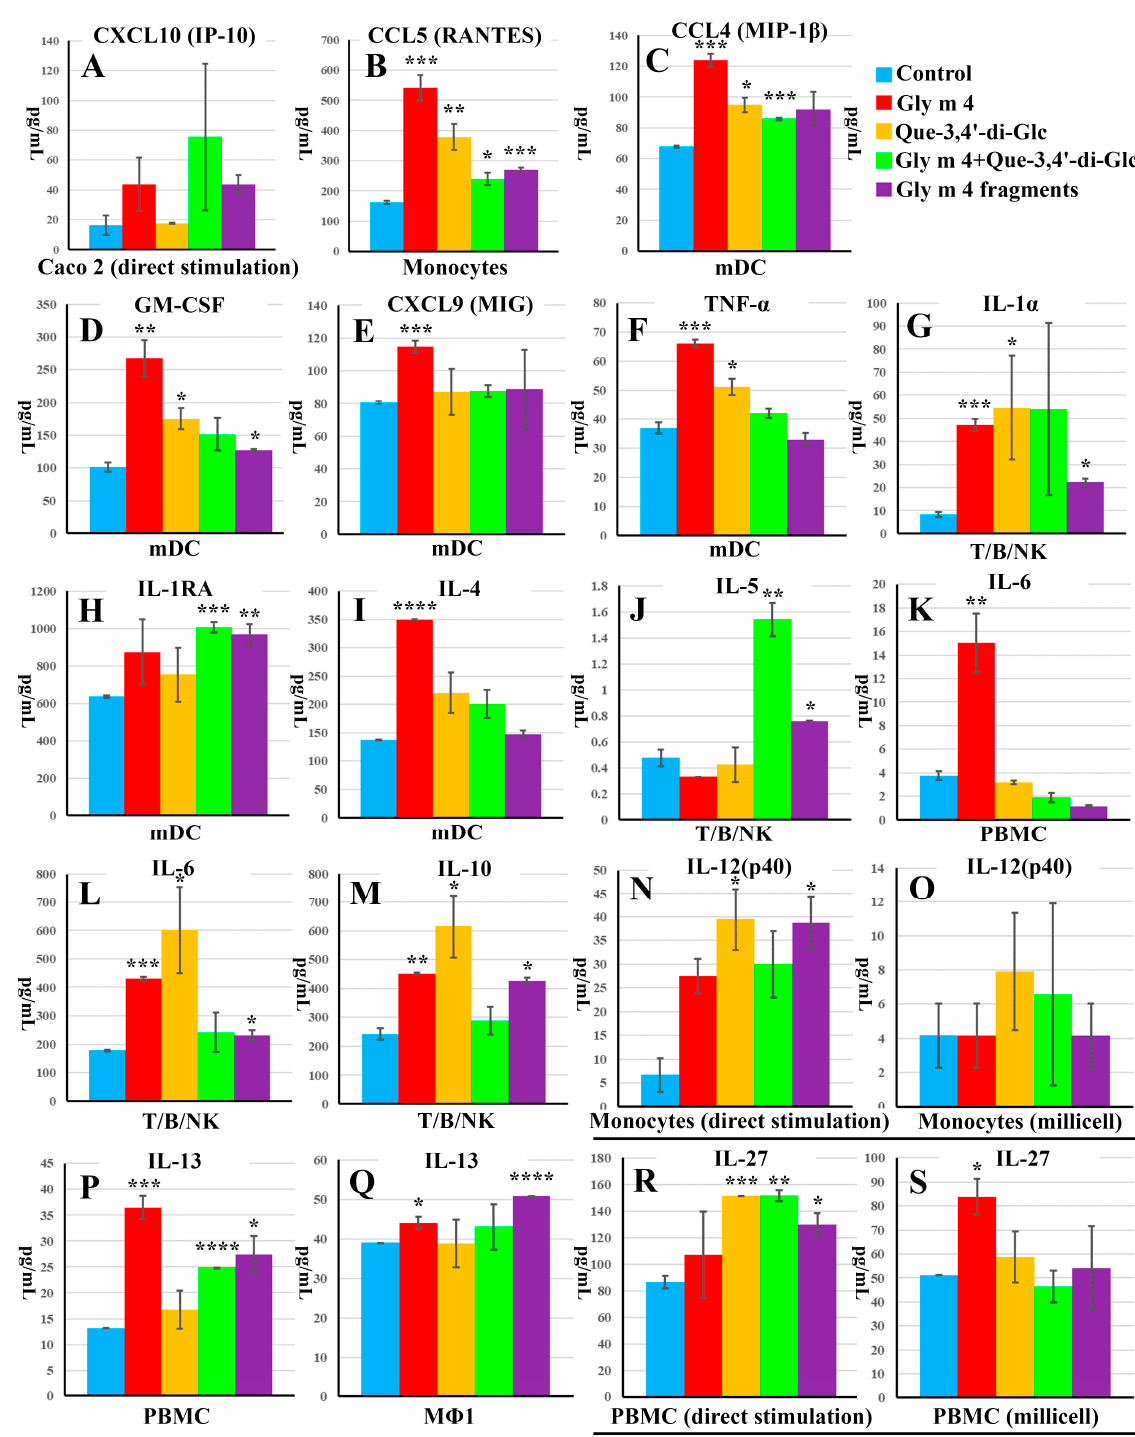
Figure 8. Cytokines and chemokines production by the Caco ‐ 2 cell line, Monocytes and PBMC (the direct stimulation) or by PBMC, T/B/NK, Monocytes, M Φ 1 and mDCs cultures from basolateral chambers (the transepithelial stimulation). ( A , N , R ) represent cytokines and chemokines, which were assessed after direct stimulation; ( B – M , O – Q , S ) represent cytokines and chemokines, which were assessed after transepithelial stimulation. Error bars represent standard deviation between two technical replications (or biological replications for the direct stimulation). Significance levels are: * p < 0.05, ** p < 0.01, *** p < 0.005, **** p < 0.001.